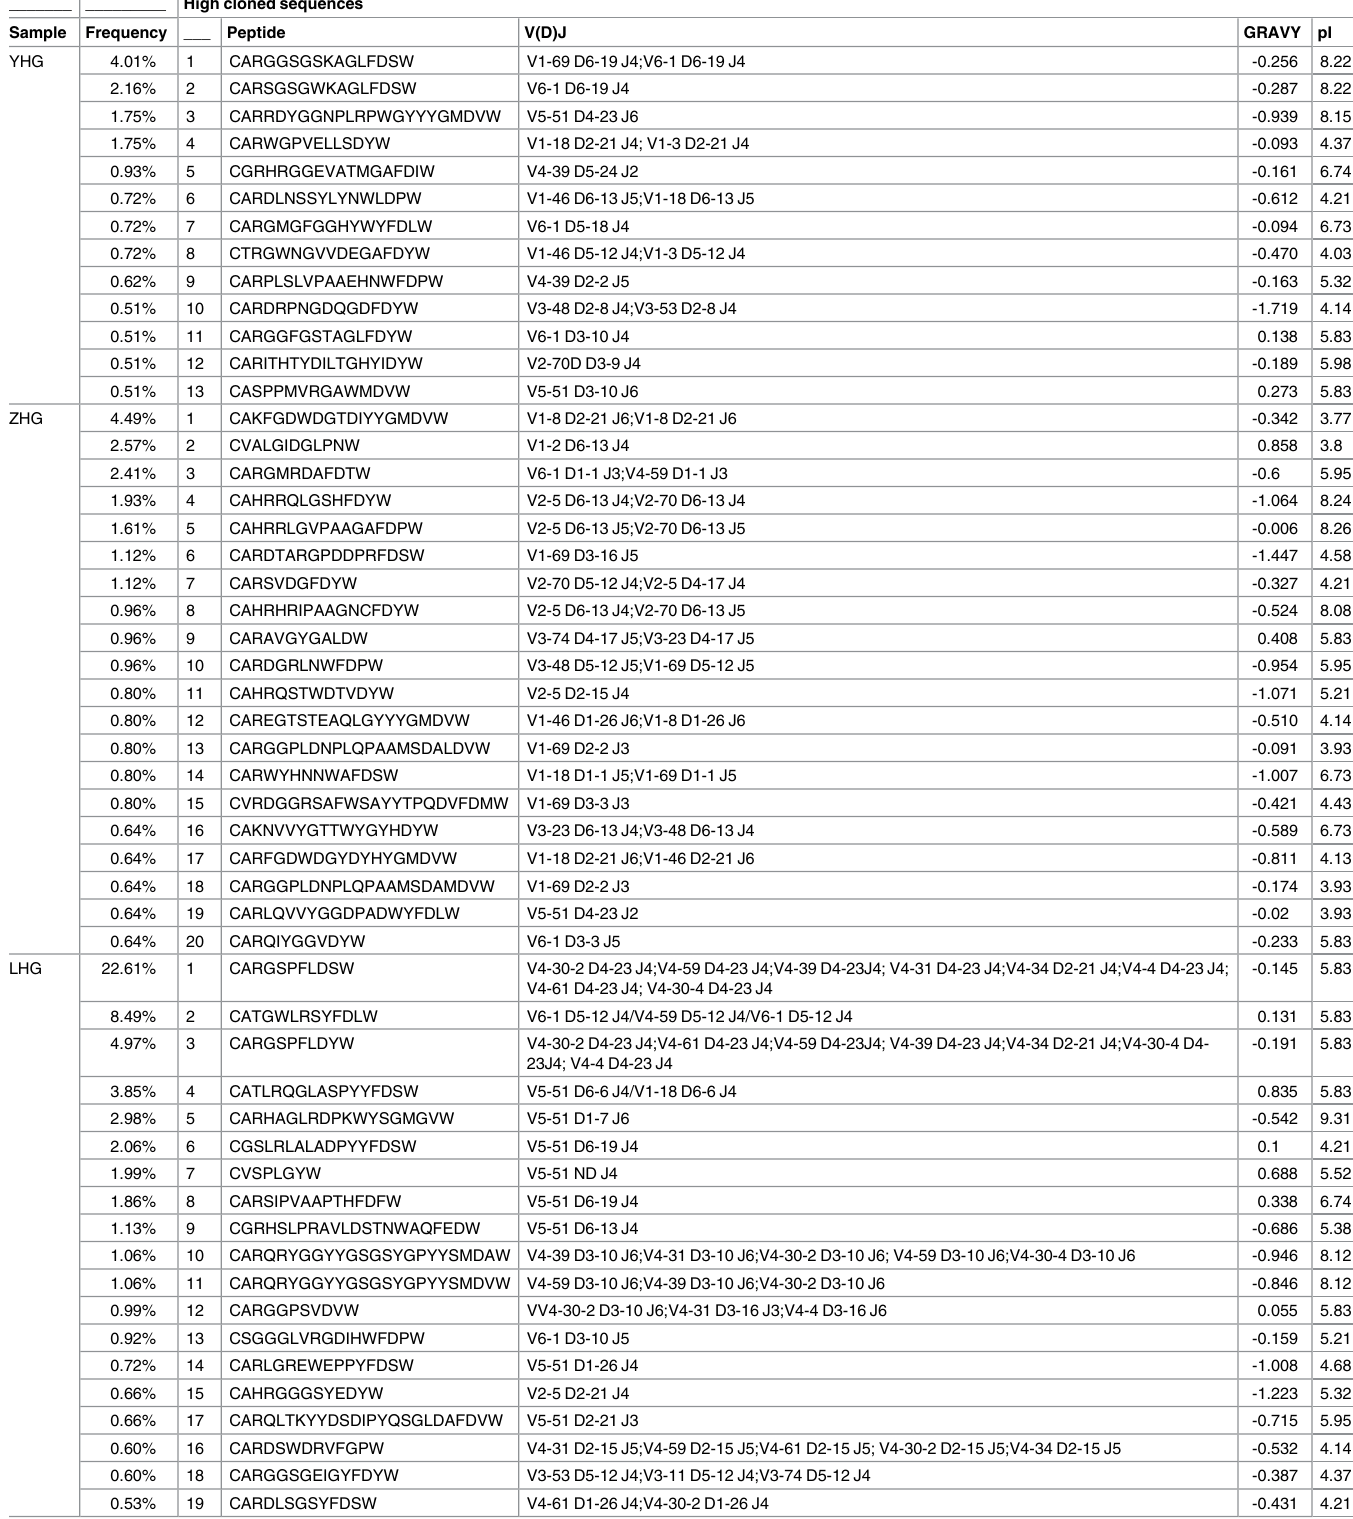
Table 5. Characteristics of high frequency CDR3 sequences ( > 0.5%) in the IgG repertoires after immunization with HBV vaccinesin 3